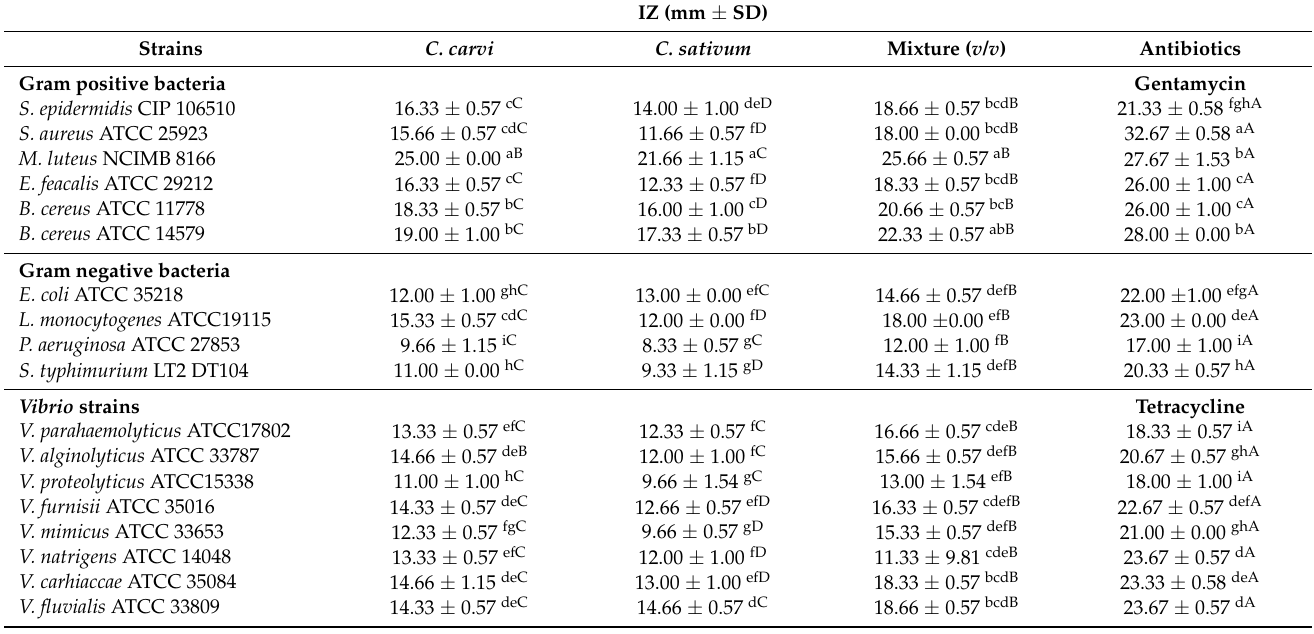
Table 3. Inhibition zones of growth (IZ mm ± SD), showing the qualitative antibacterial activity of two EOs ( C. carvi and C. sativum ) and their mixture against human pathogenic bacteria compared to standard antibiotics (gentamycin and tetracycline).